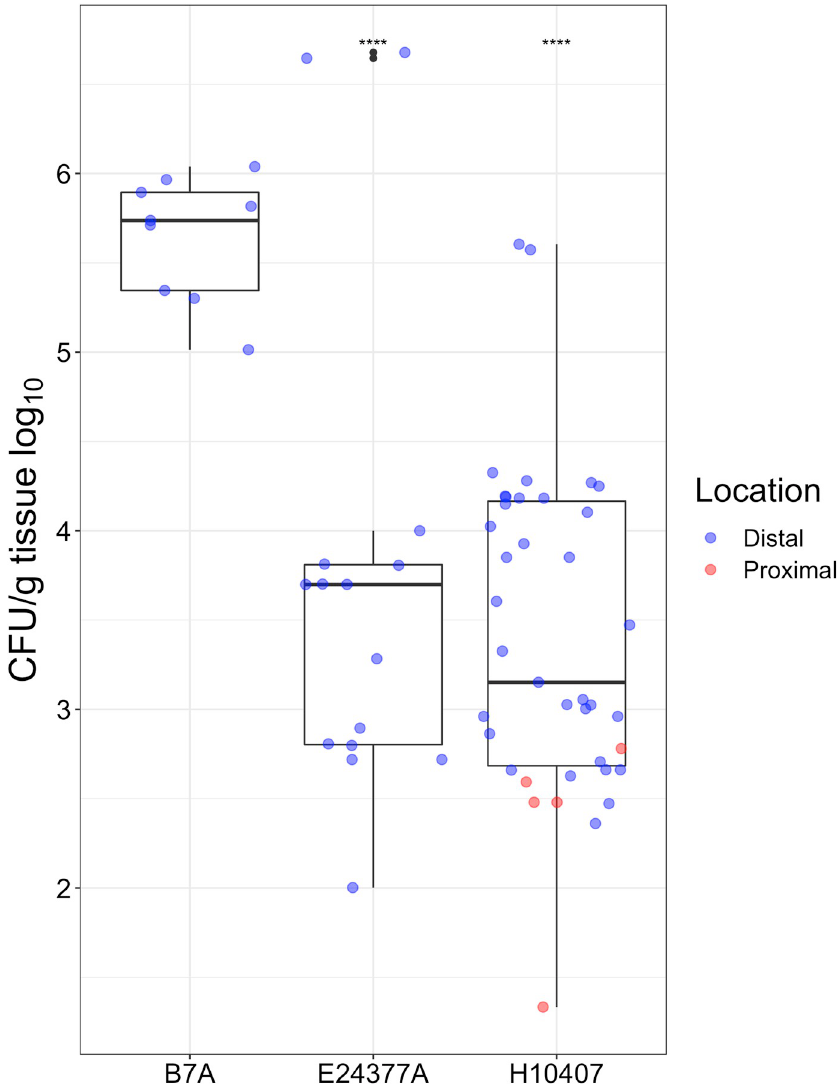
Fig 2. Colonization of na ï ve rabbits with ETEC strains, showing location of the small intestine sampled (distal: blue, proximal: red). Shown are plate counts for each rabbit (single points), with boxplots overlayed displaying the median and interquartile range in black. The strain of ETEC used for the challenge is listed at the bottom. ���� : p < = 0.0001 when Student’s T-test performed with